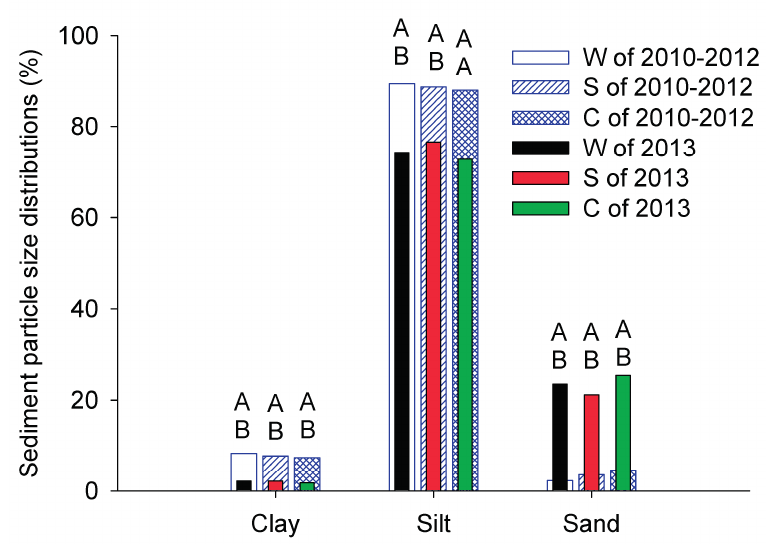
Figure 9. Sediment particle size distributions in the “extreme year” and “normal